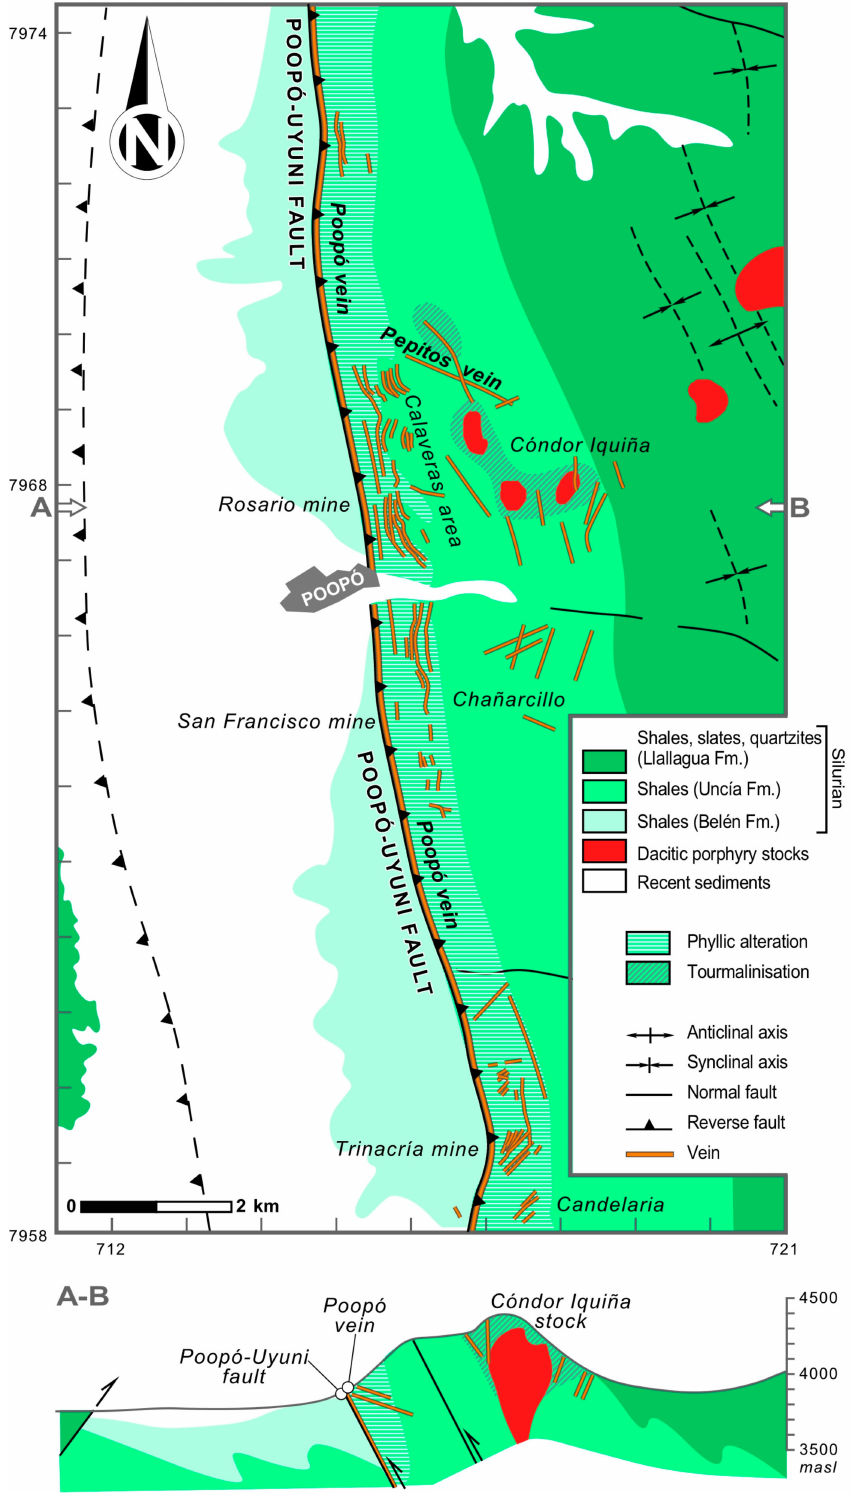
Figure 2. Local geological map of the Poop ó area, redrawn from Reference